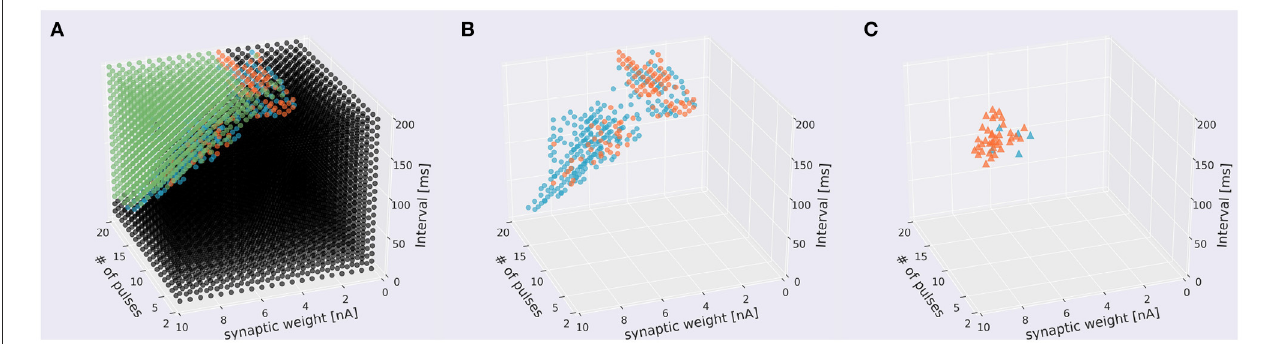
FIGURE8 Distribution of sequences under the presence of learning. (A) Scatter plot. A 1,310 sequences emit spikes in both directions, 235 were IN-only, 106 were OUT-only, and 5,949 sequences did not cause in either direction. Conventions as in the top panel of Figure 5A. (B) The same plot leaving only direction-sensitive sequences (blue: OUT direction; orange: IN direction) as in the bottom panel of Figure 5A. (C) Sequences that were able to be changed the direction before and after learning. Blue and orange dots represent sequences that changed the direction from IN to OUT and from OUT to IN to emit spikes,